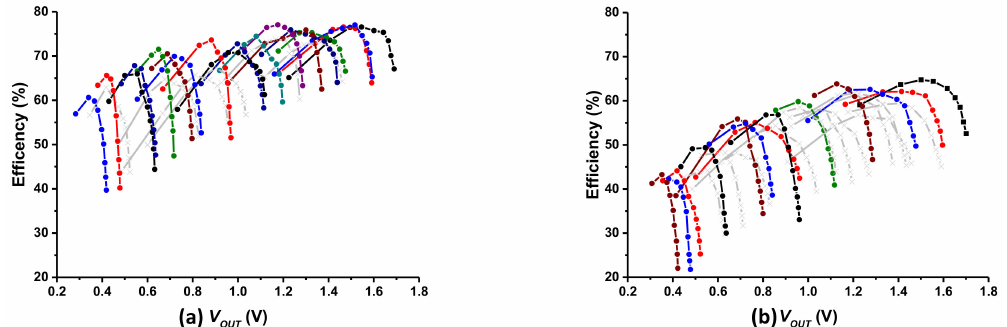
Figure 18. Efficiency vs. V OUT at I LOAD = 500 nA ( a ) Only 1 (smallest) leaf enable (Min. switch size). ( b ) All leaves enabled (Max. switch